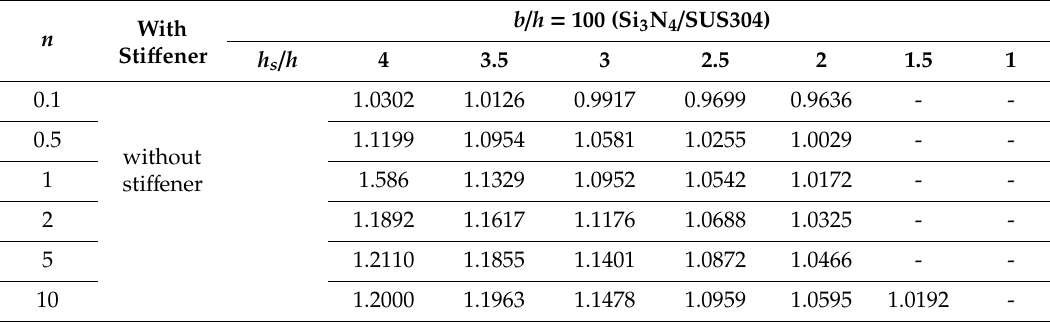
Table 6. The mass reduction between Si 3 N 4 / SUS304 plate with and without a central sti ff ener ( b / h = 100).